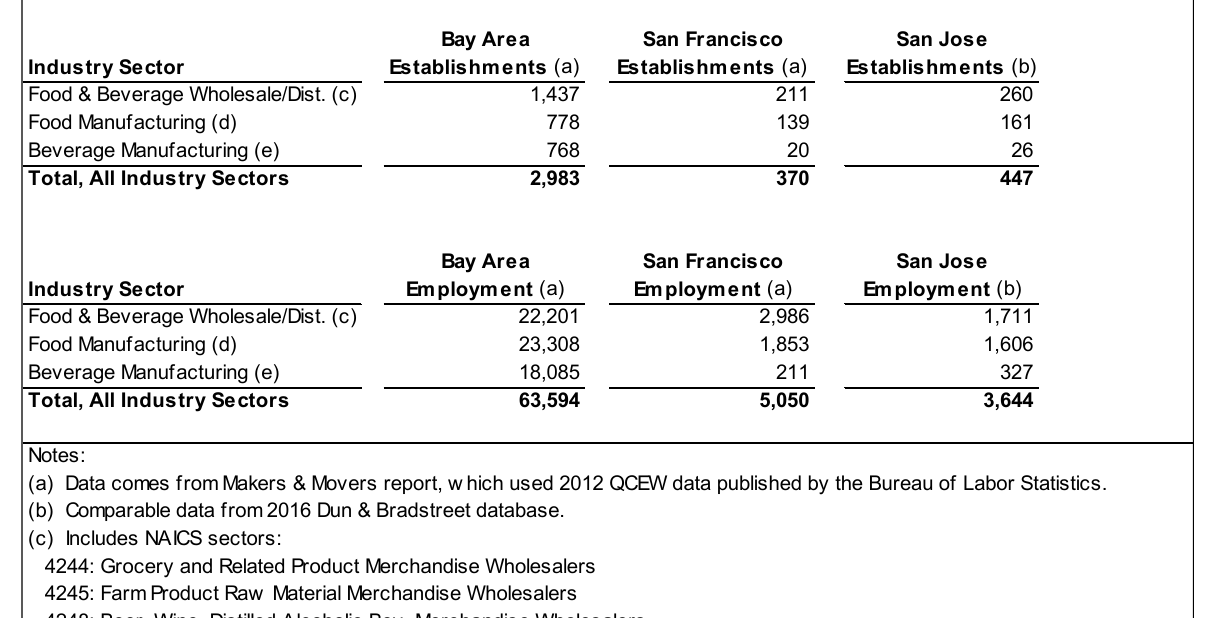
Table 4. Establishment and Employment by Industry Sector, Bay Area, San Francisco and San Jose